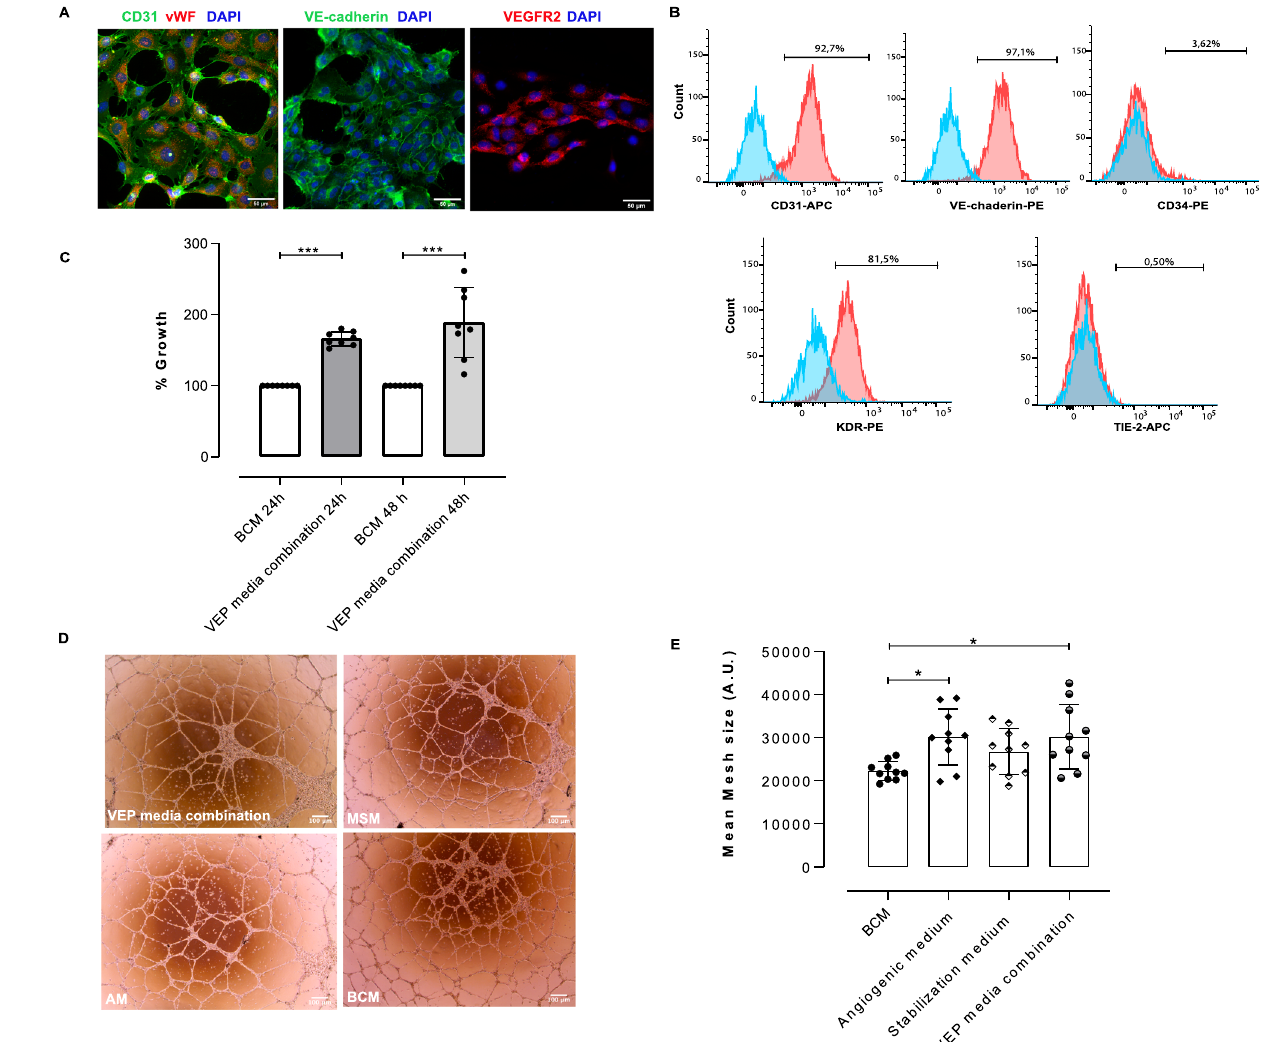
Fig. 1 | BOEC functional characterization for VEPs assembly. A Immuno fl uorescence image of BOEC endothelial phenotyping CD31 (green) and Von Willebrand factor (vWF-red), VE-cadherin (green),vascularendothelial growth factorreceptor2(VEGF-R2-red)andDAPI(blue).Scalebarin µ m.Twoindependent experiments; the representative images were shown; B Flow cytometry BOECs phenotyping for CD31, VE-cadherin, CD34 and KDR (blue and red: histogram for isotype control and positive cells respectively); C WST-1 assay for BOEC prolifera- tion in the presence of standard BOEC culture medium (BCM) or VEP media com- bination,( n =8biologicalreplicates)for24or48h.Valuespresentedasmean±SD. BCM vs . VEP media combination 24h *** p =0.0002; BCM vs . VEP media